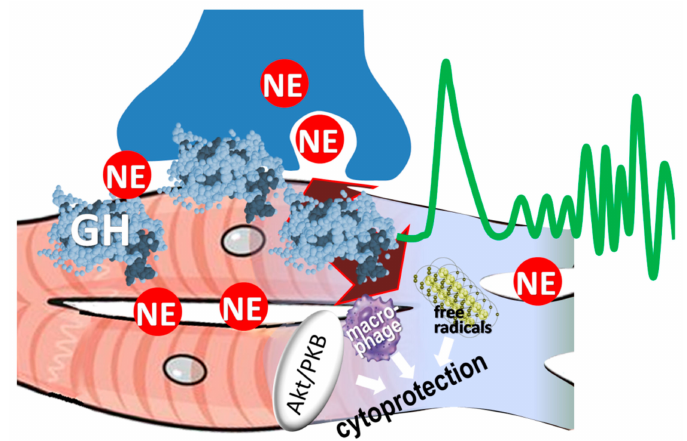
Figure 3. Proposed mechanisms of antiarrhythmic e ff ects of GH. Two mechanisms may explain the antiarrhythmic e ff ects of growth hormone, namely cytoprotection and reduced norepinephrine (NE) interstitial